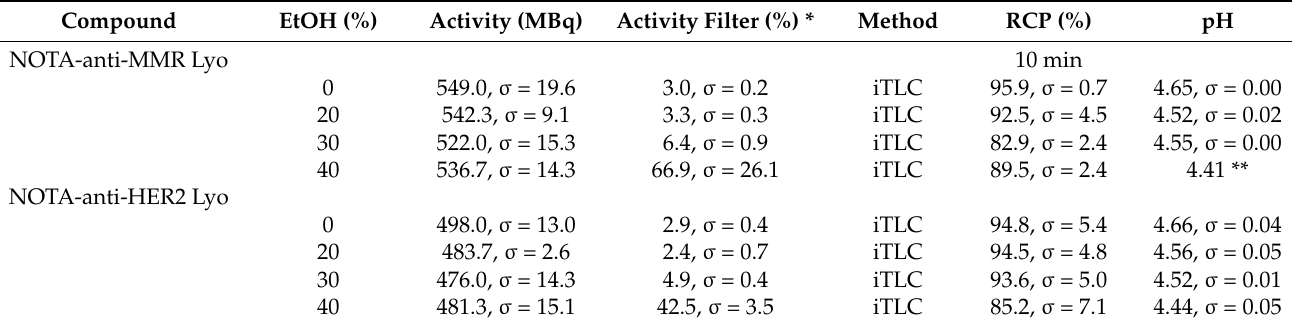
Table 2. Effect of EtOH on 68 Ga labeling of lyophilized